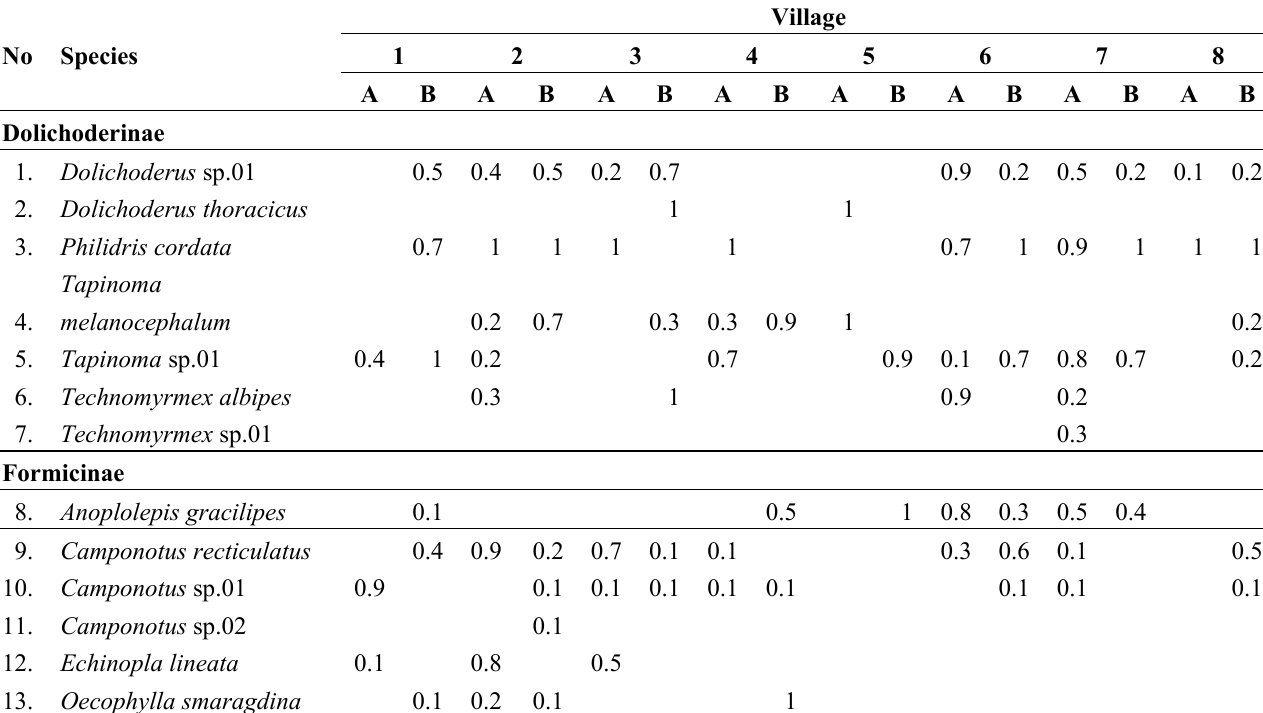
Table S1. The occurrence of ant species (proportion of trees occupied, 10 cacao trees observed) collected in the 16 cacao agroforestry plots in eight villages (1: Berdikari, 2: Sintuwu, 3: Bulili, 4: Pandere, 5: Sidondo, 6: Boladangko, 7: Toro, and 8: Lempelero) with different land-use (A: shaded, B: unshaded cacao agroforestry). Morphospecies were based on the different of external